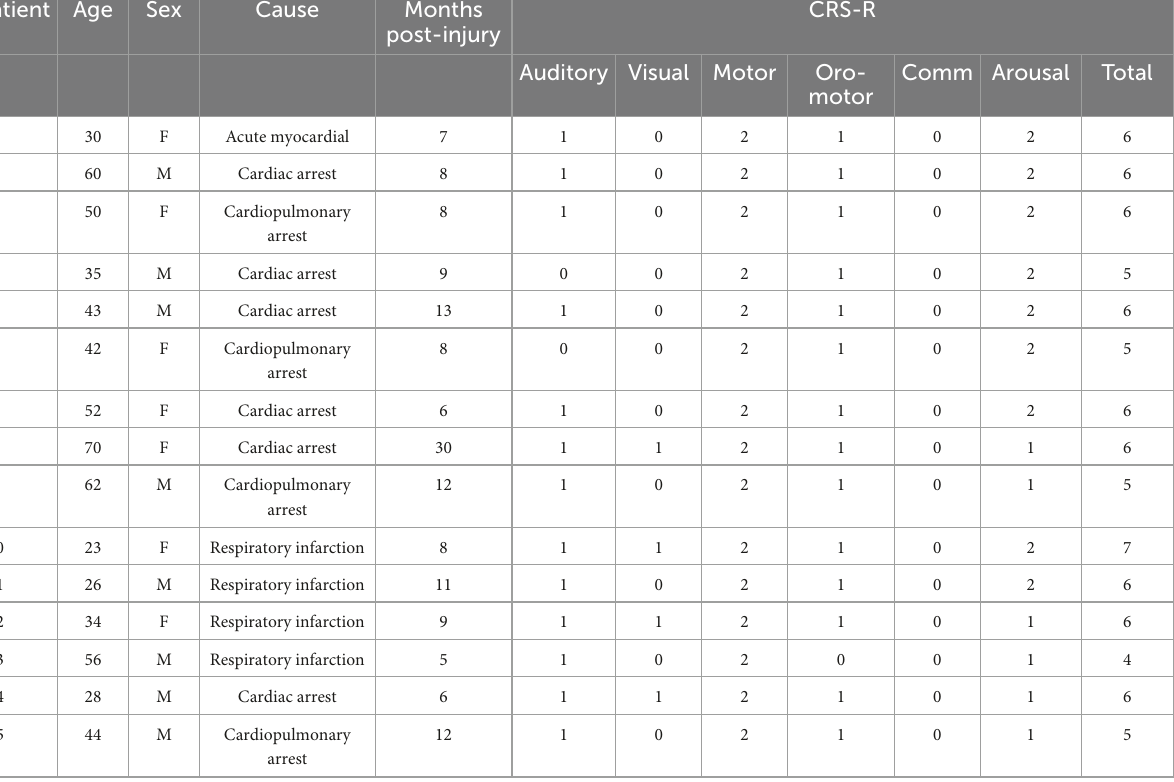
TABLE 1 Demographic details for the